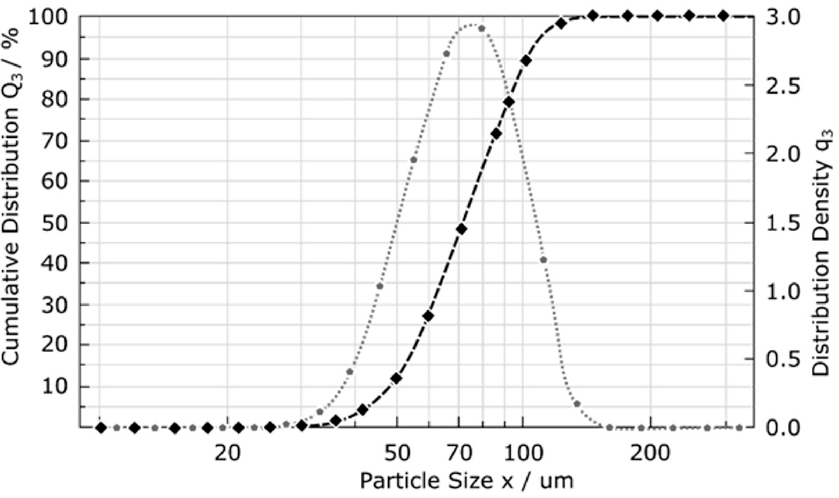
Figure 3. Analysis of the size distribution of the Ti-55511 powder fractions; dotted line—cumulative distribution, dashed line—distribution density [17].